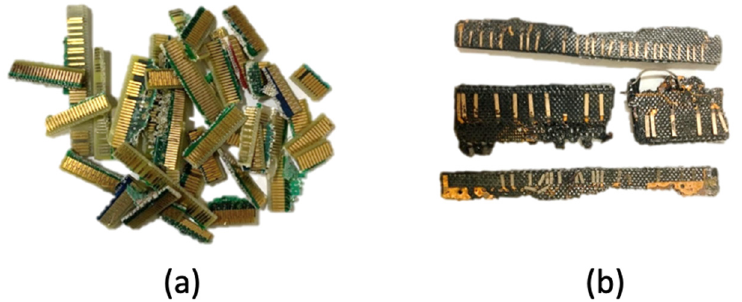
Figure 10. Macroscopic aspects of the WEEE samples: ( a ) before thermal processing; ( b ) after thermal processing.